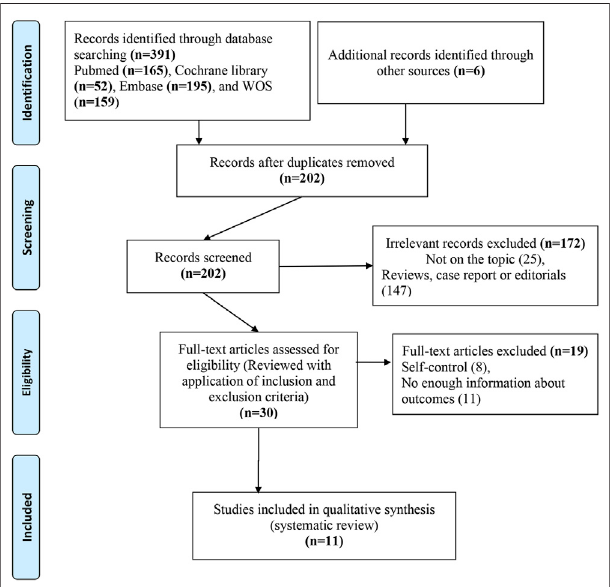
FIGURE 1 | PRISMA fl owchart of the data search.